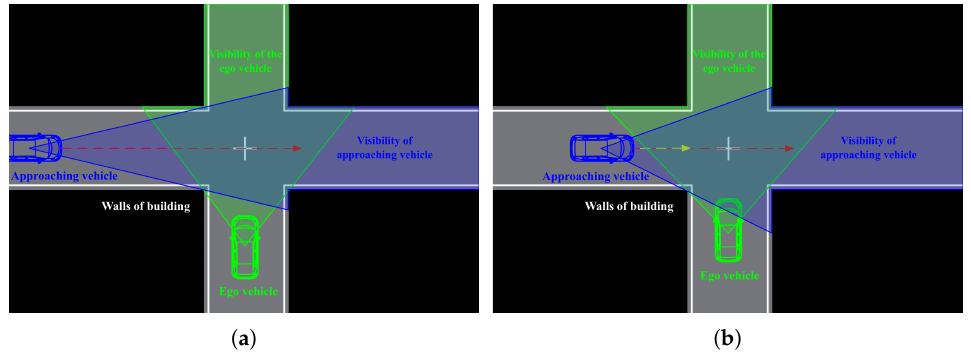
Figure 2. A possible behavior change of an occluded vehicle after it has observed the ego vehicle. ( a ) An occluded vehicle travels toward the intersection at a constant speed. ( b ) After observing the ego vehicle, an occluded vehicle may change its